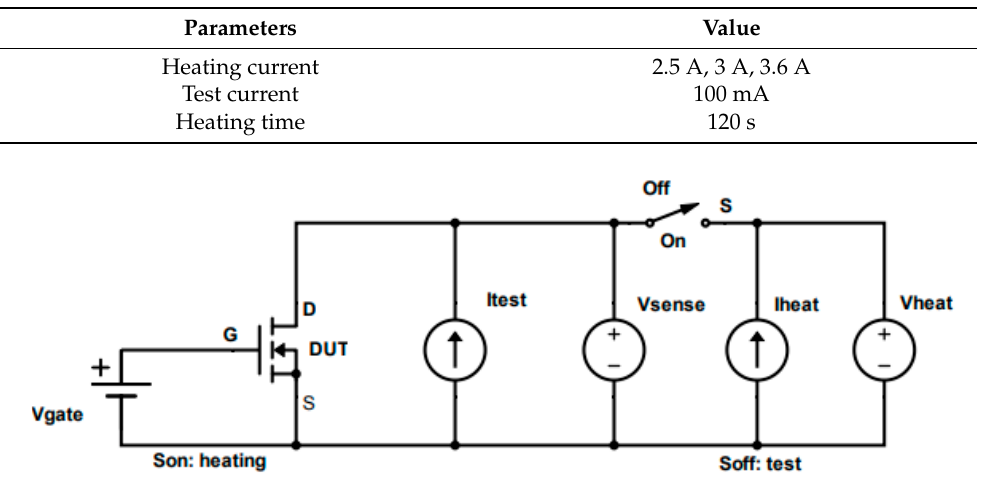
Figure 6. Schematic of the electrical circuit for V ds measurement.